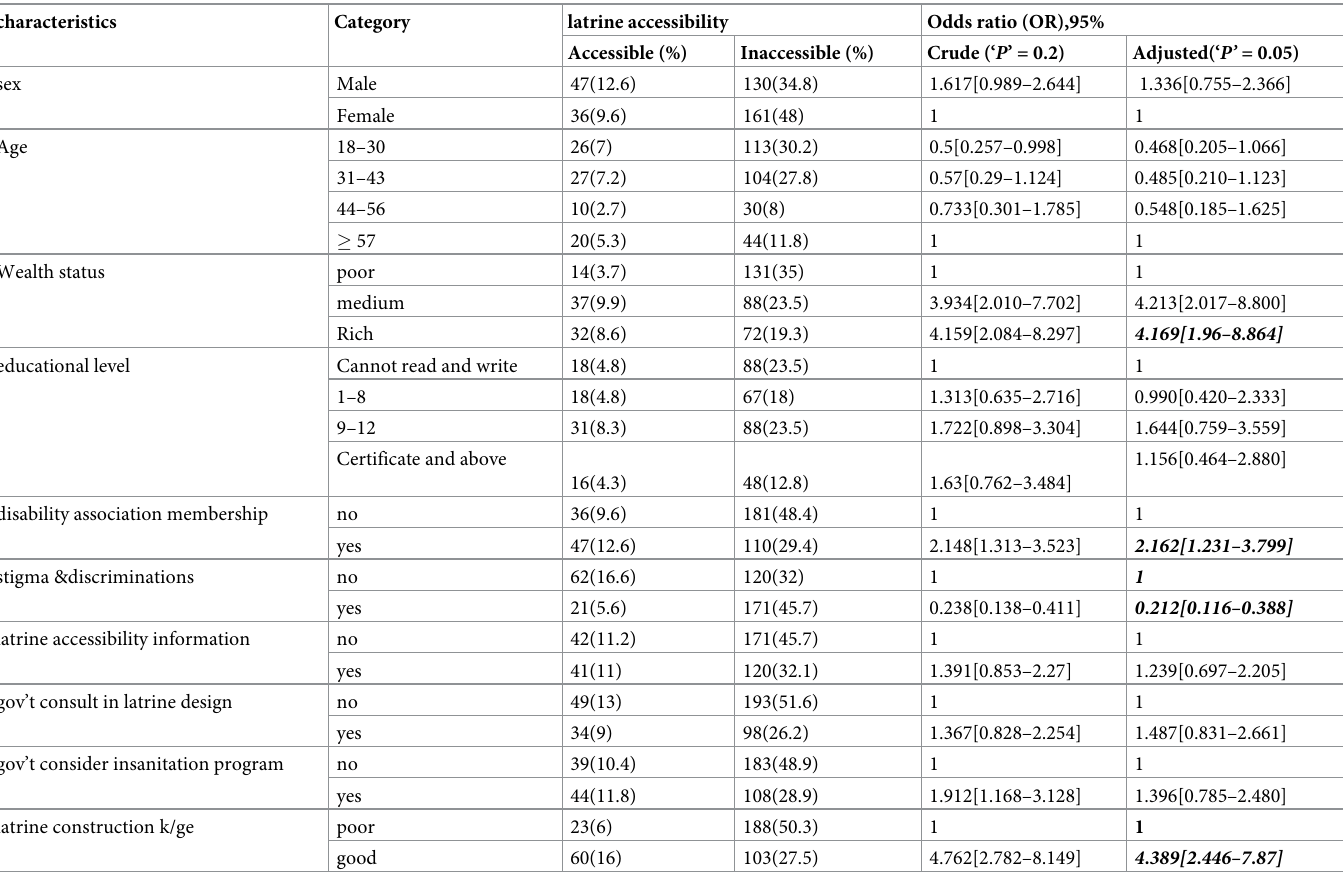
Table 3. Bi-variable and multi-variable logistic regression on factors associated with latrine accessibility among PwPDs in Kombolcha town in April 2020 (n =